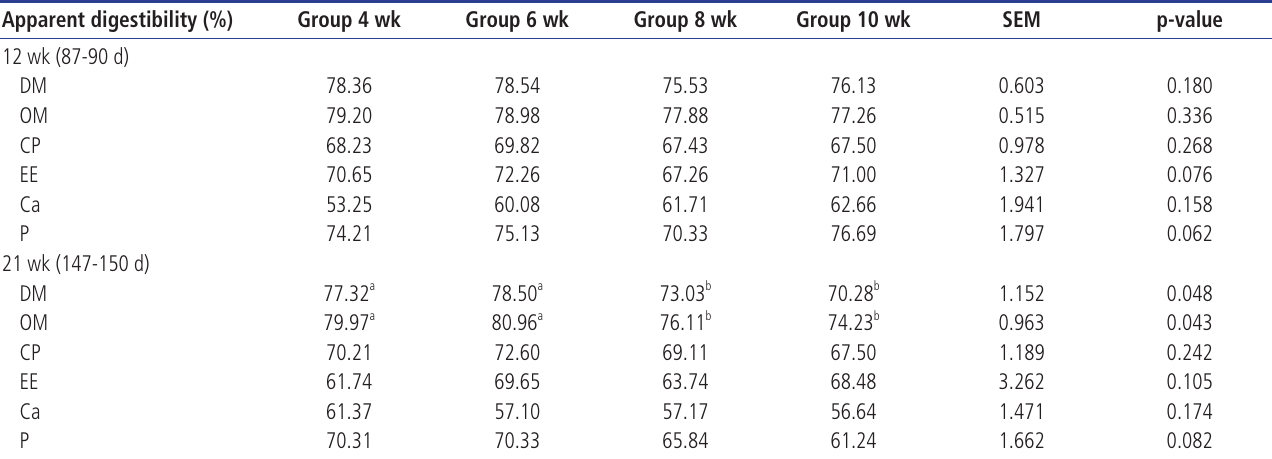
Table 3. Effect of weaning age on nutrients apparent digestibility (%) by calves in two periods Apparent digestibility